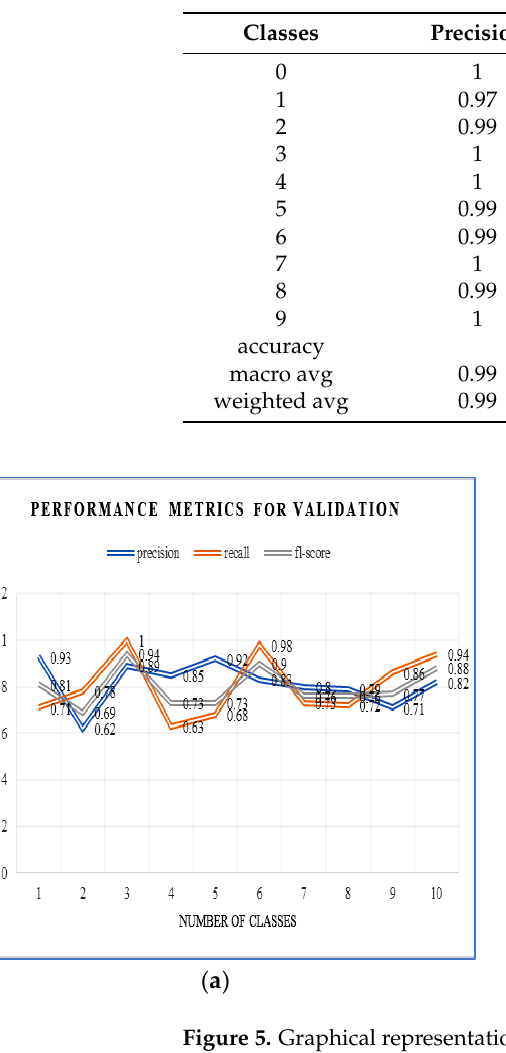
Table 4. Performance metrics in training.